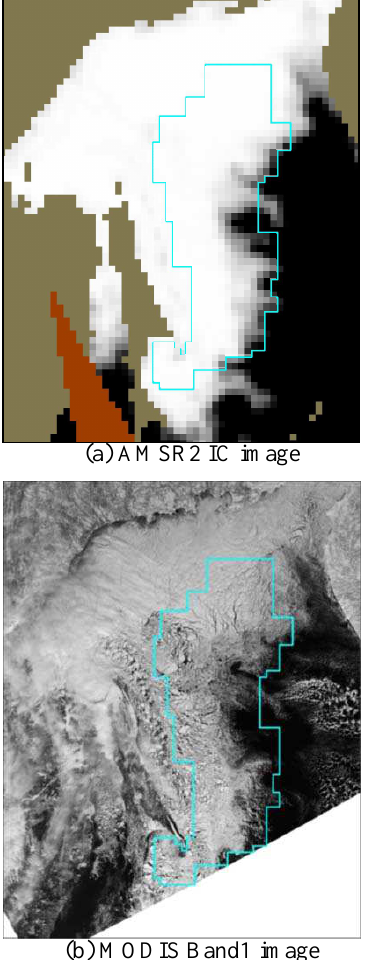
Figure 6. Test site for evaluating the threshold level of MODIS data for binarization